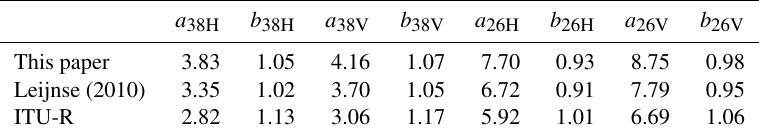
Figure 4. Disdrometer-derived rainfall intensities plotted against disdrometer-derived specific attenuation at several frequencies and polar- izations of the incident radiation. The black line indicates the fitted curves: (a) 38GHz horizontal, (b) 38GHz vertical, (c) 26GHz horizontal, and (d) 26GHz vertical. Table 2. Coefficients and exponents ( a and b parameters) of the R – k relationship derived from different sources for frequencies of 38 and 26GHz for both horizontally and vertically polarized radiation. Unit of a is mmh − 1 dB − b km b